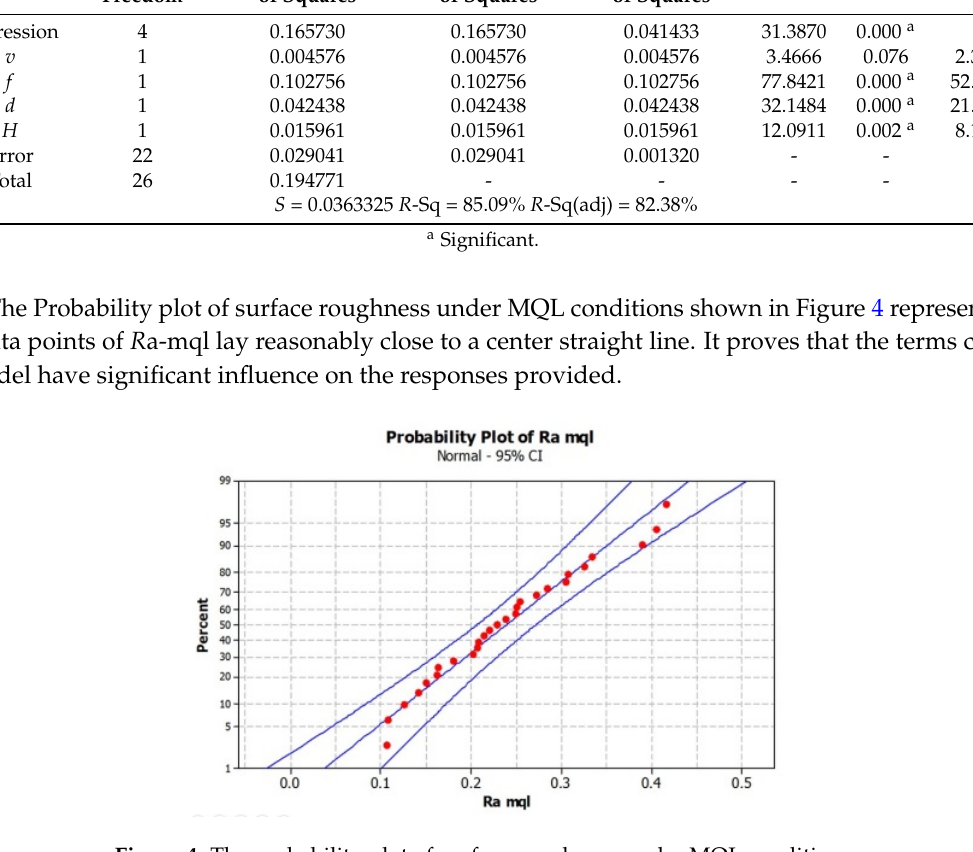
Table 12. Analysis of variance for the linear regression model.